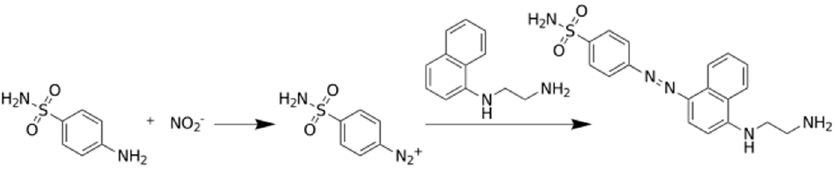
Figure 1. The Griess reaction for the photometric determination of nitrite ion.